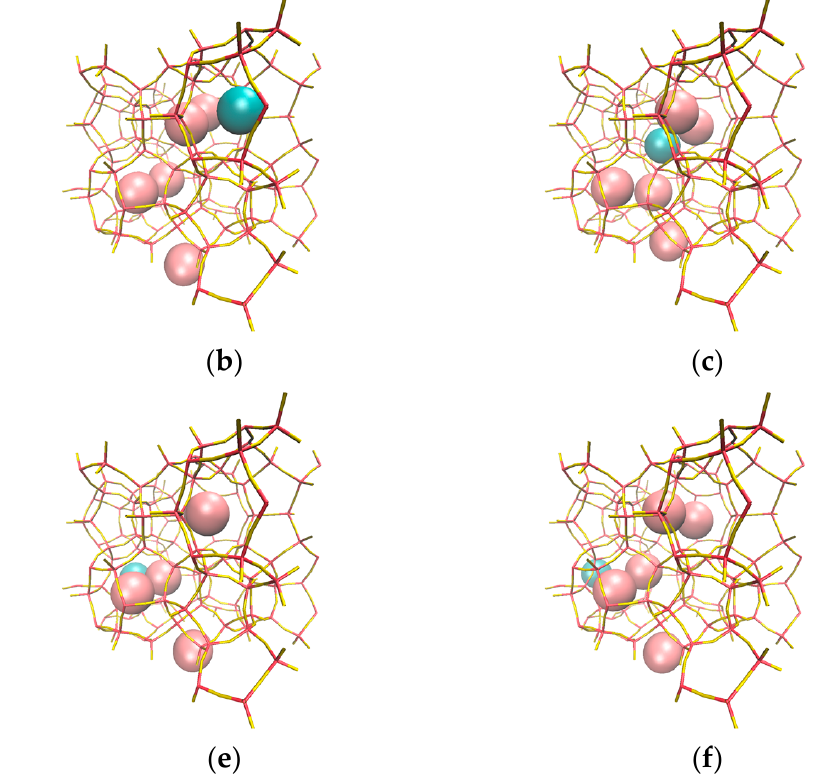
Figure 14. The absence of Xe pre-filled cages ( a ) causes Xe to accumulate on the surface, thus limiting Kr permeation, which, in addition, accumulates inside inner cages. Molecular visualization showing the effect of Xe pre-filled zeolite cages on Kr permeation, where we see Kr atom approaches cage window ( b ), Kr inside first inner cage ( c ), Kr jumping from and into inner cages and passing to the complete permeation region ( d ), ( e ), and ( f ) respectively.